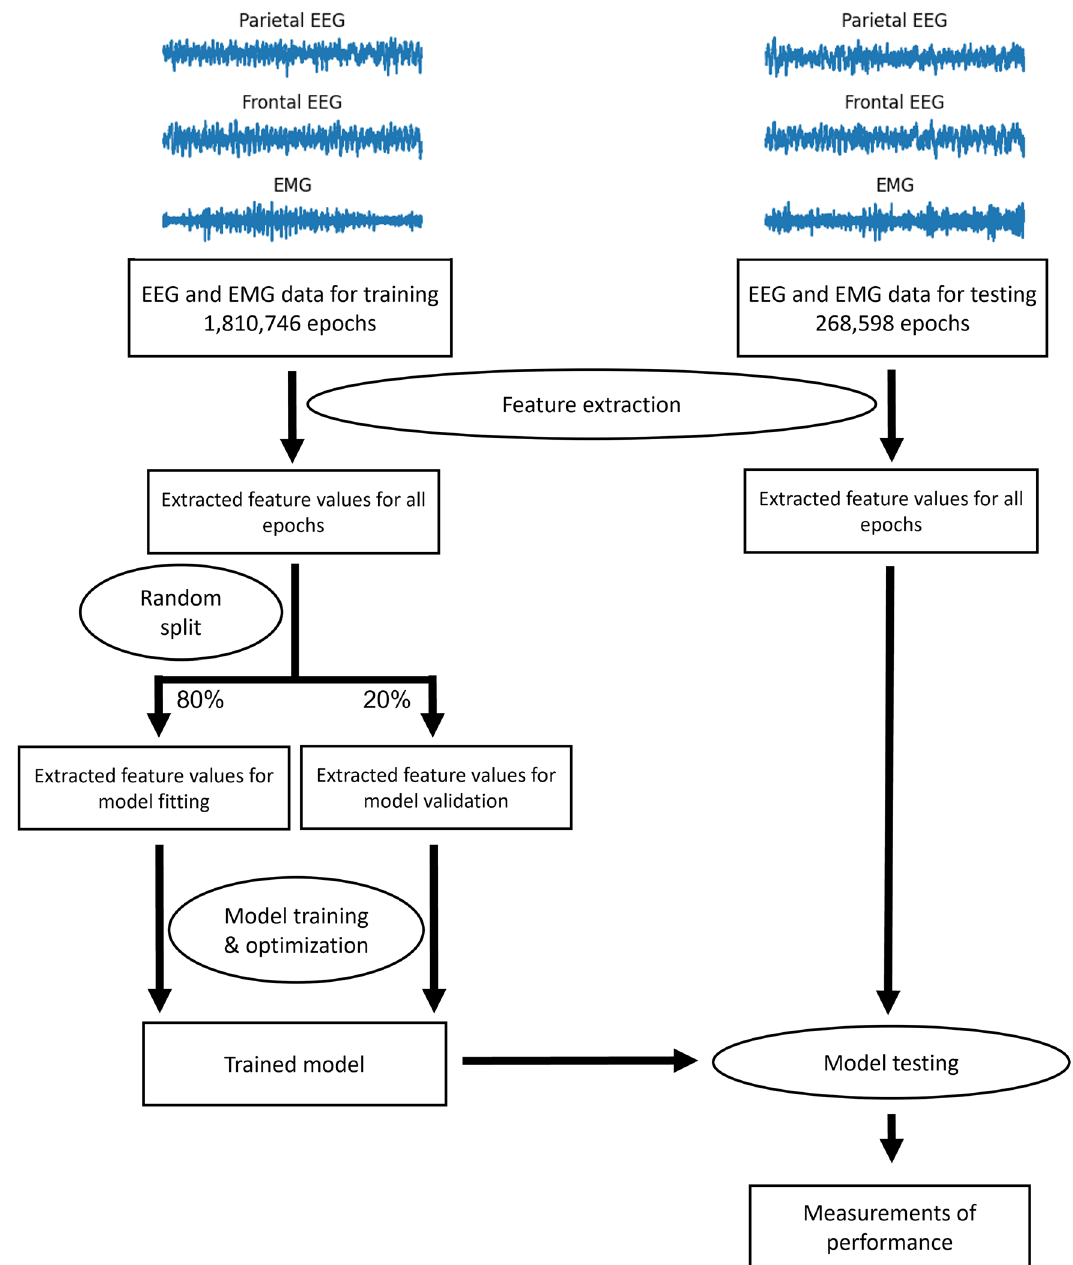
Figure 2. Schematic diagram of the training and testing processes for the LightGBM